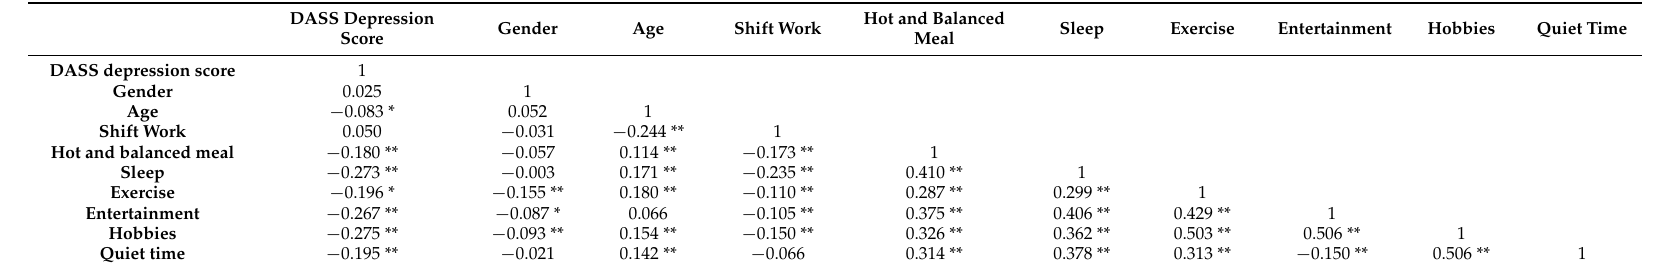
Hot and Balanced Meal Sleep Exercise Entertainment Hobbies Quiet Time